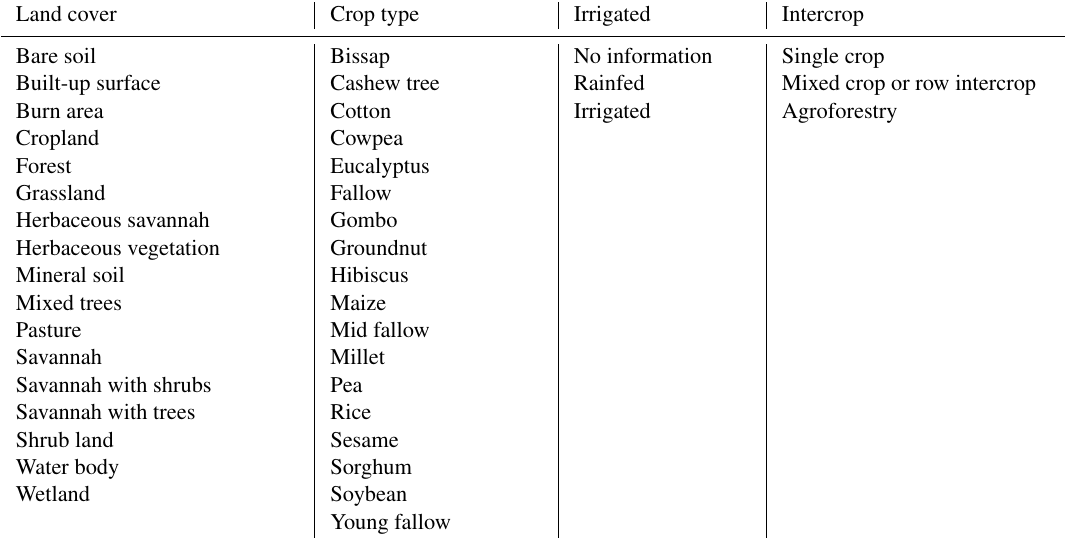
Table A1. Example of scrollable lists used in the